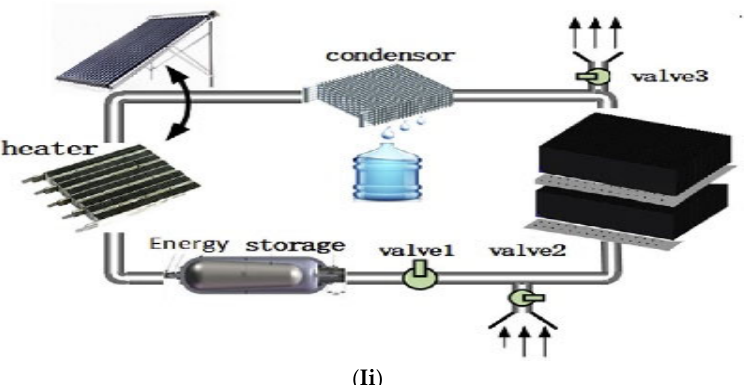
Figure 4. ( a ) Heat ‐ driven atmospheric water harvester [66]. ( b ) Air ‐ cooled adsorption water har ‐ vesting system [69]. ( c ) Solar powered atmospheric water harvesting (LiCl/MgSO 4 /ACF) [70]. ( d ) Hollowmicrospheres for the harvesting of atmospheric water [74]. ( e ) Multicyclic sorption ‐ based water harvesting system [72]. ( f ) Atmospheric water harvesting with nanofibrous membranes [73]. ( g ) Water harvesting powered by natural sunlight [75]. ( h ) Atmospheric water harvesting based